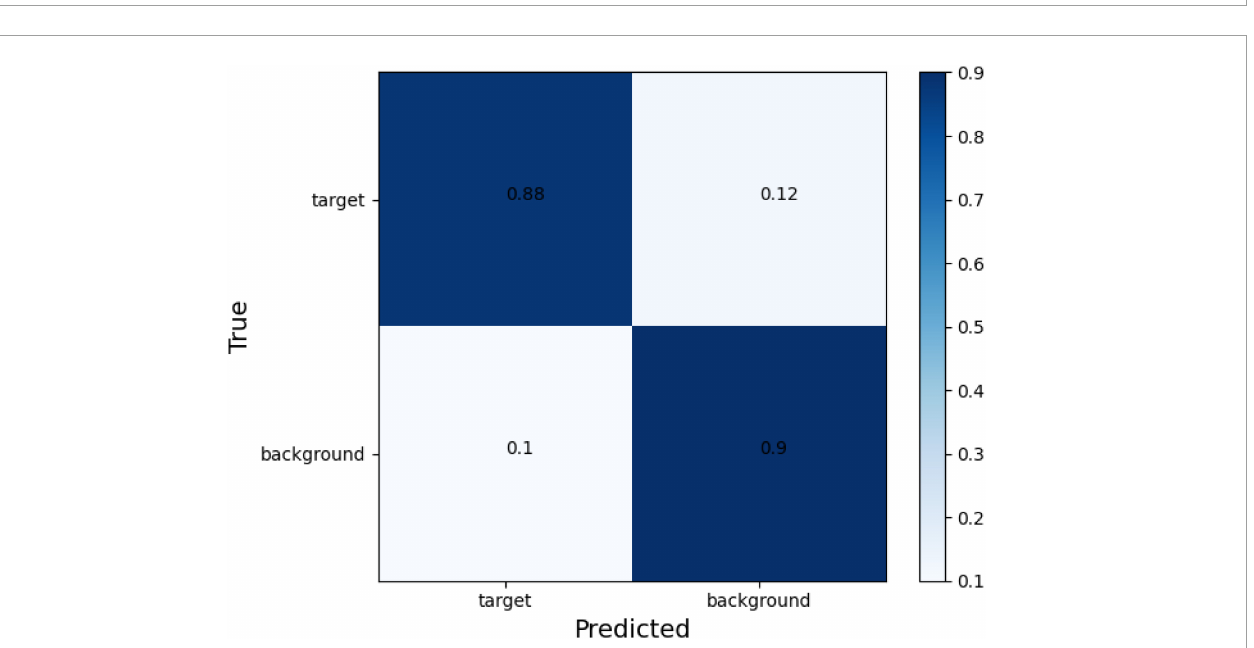
FIGURE6 Confusion matrix of tear meniscus